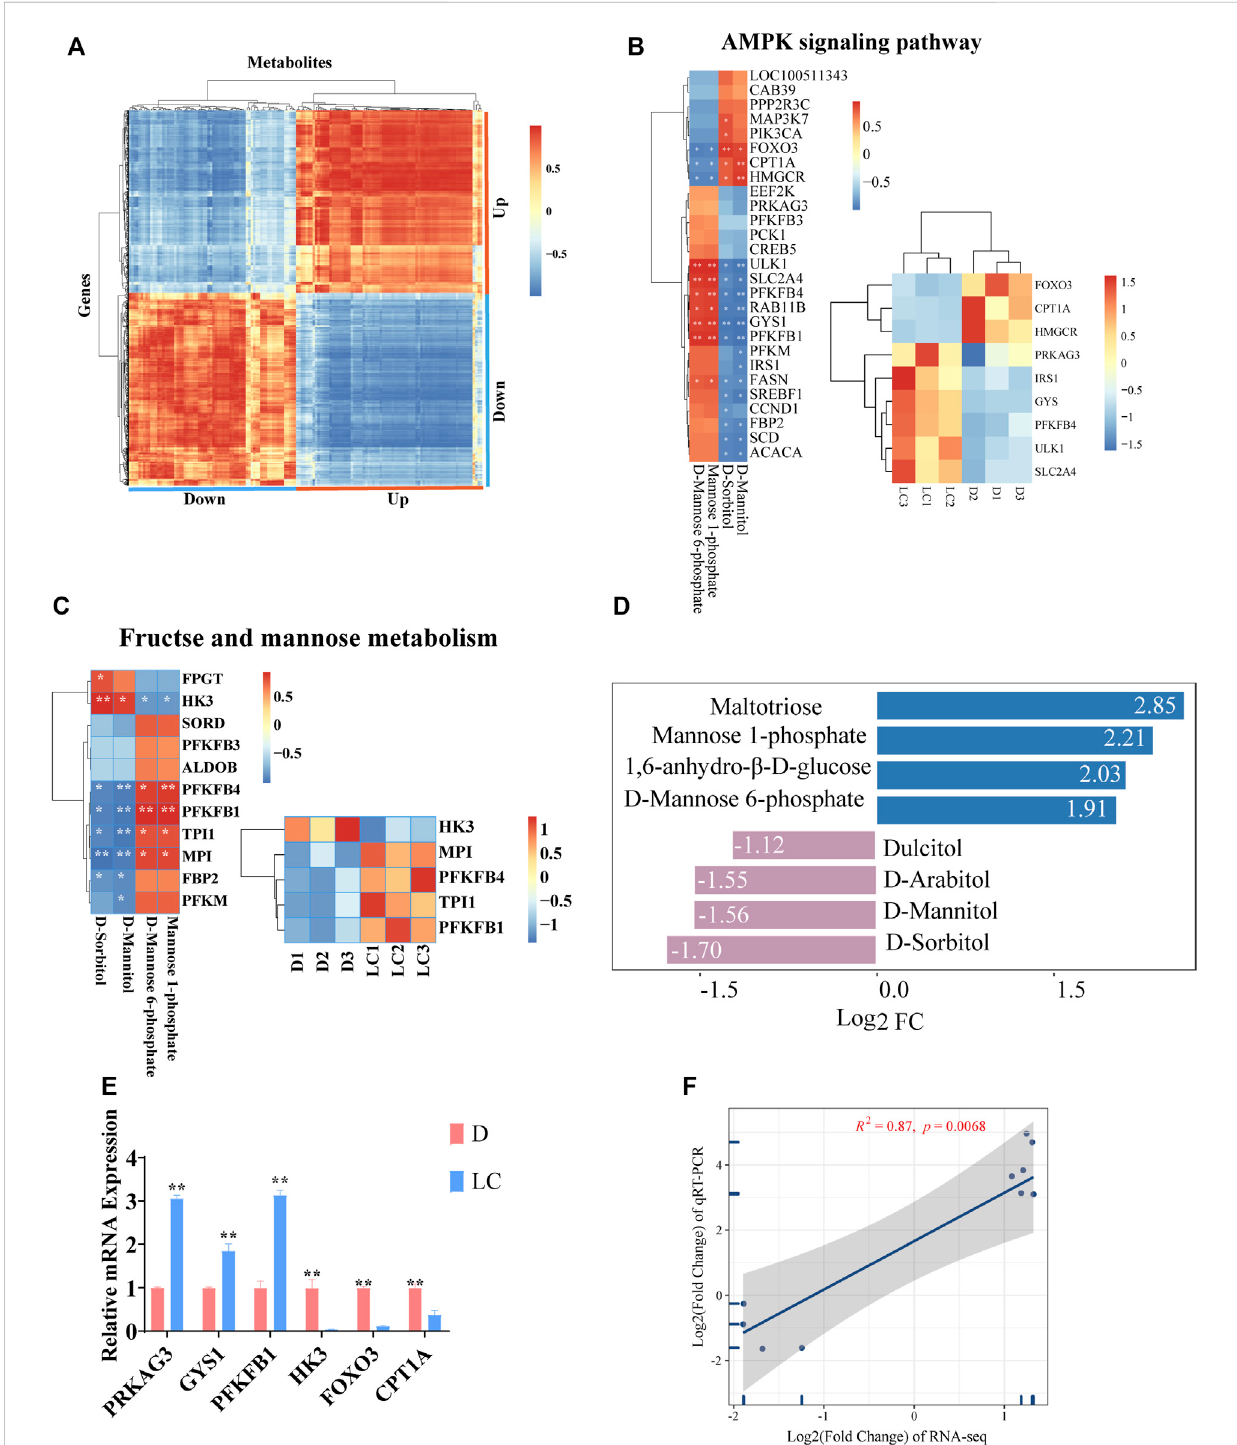
FIGURE 4 Integrativeanalysis ofmetabolomeandtranscriptome. (A) HeatmapofcorrelationbetweenallupregulatedanddownregulatedDEGsandDAMs. (B) Correlation between genes and metabolites, and the expression level of several key genes in AMPK signaling pathway in different individuals. (C) Correlation between genes and metabolites, and the expression level of several key genes in fructose and mannose metabolism in different individuals. (D) TheLog2FoldChange(FC)ofseveralmetabolitesinvolvedinthesetwopathways. (E) RelativemRNAexpressionlevel(qPCR)ofseveralgenesthat are essential in these two pathways. (F) Linear regression between Log2 FC of gene expression (RNA-seq) and Log2 FC of relative mRNA expression